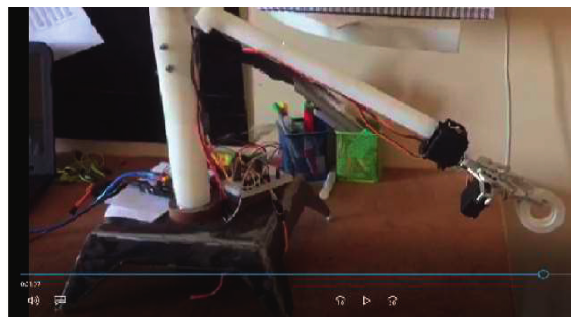
Figure 7: Pick-and-place